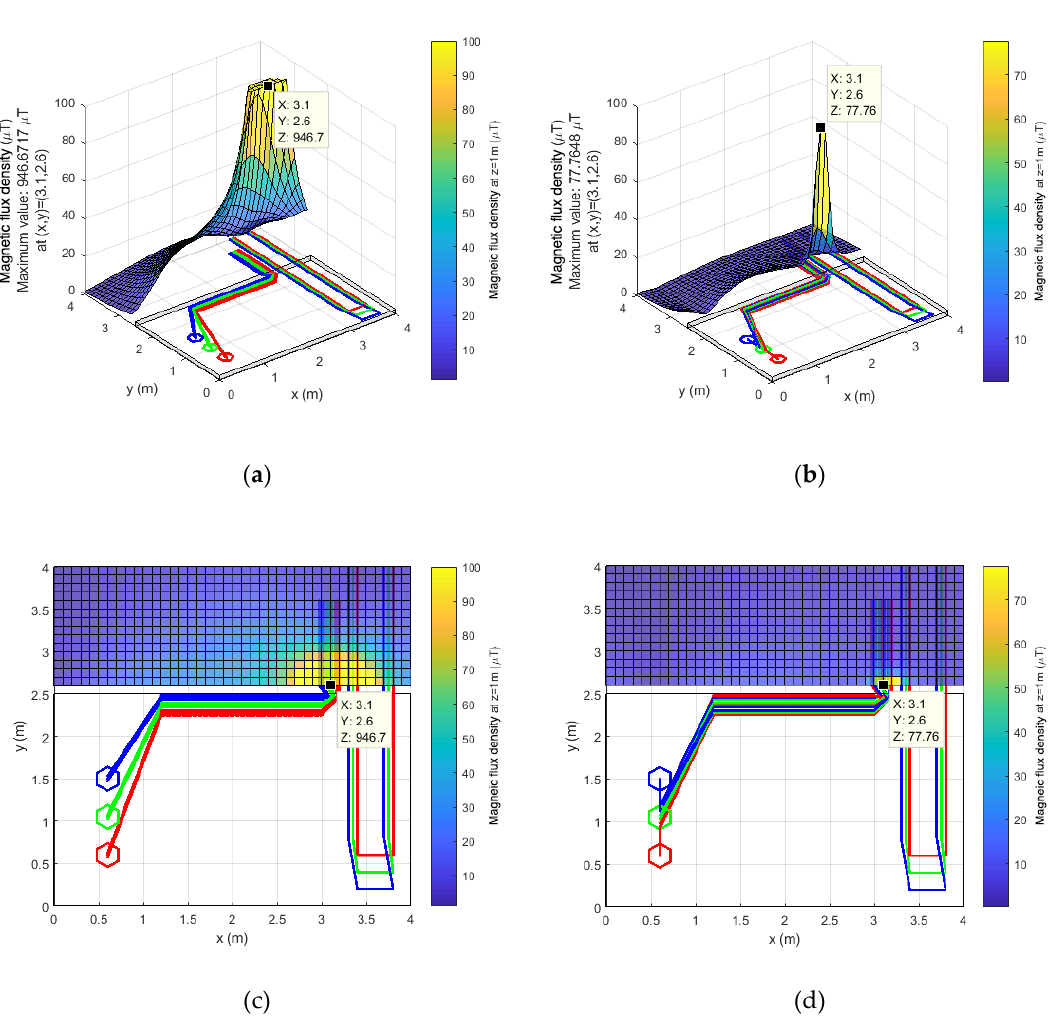
Figure 14. MFD on the sidewalk in 3D using ( a ) the original layout and ( b ) the proposed alternative. MFD on the sidewalk in 2D using ( c ) the original layout and ( d ) the proposed alternative.